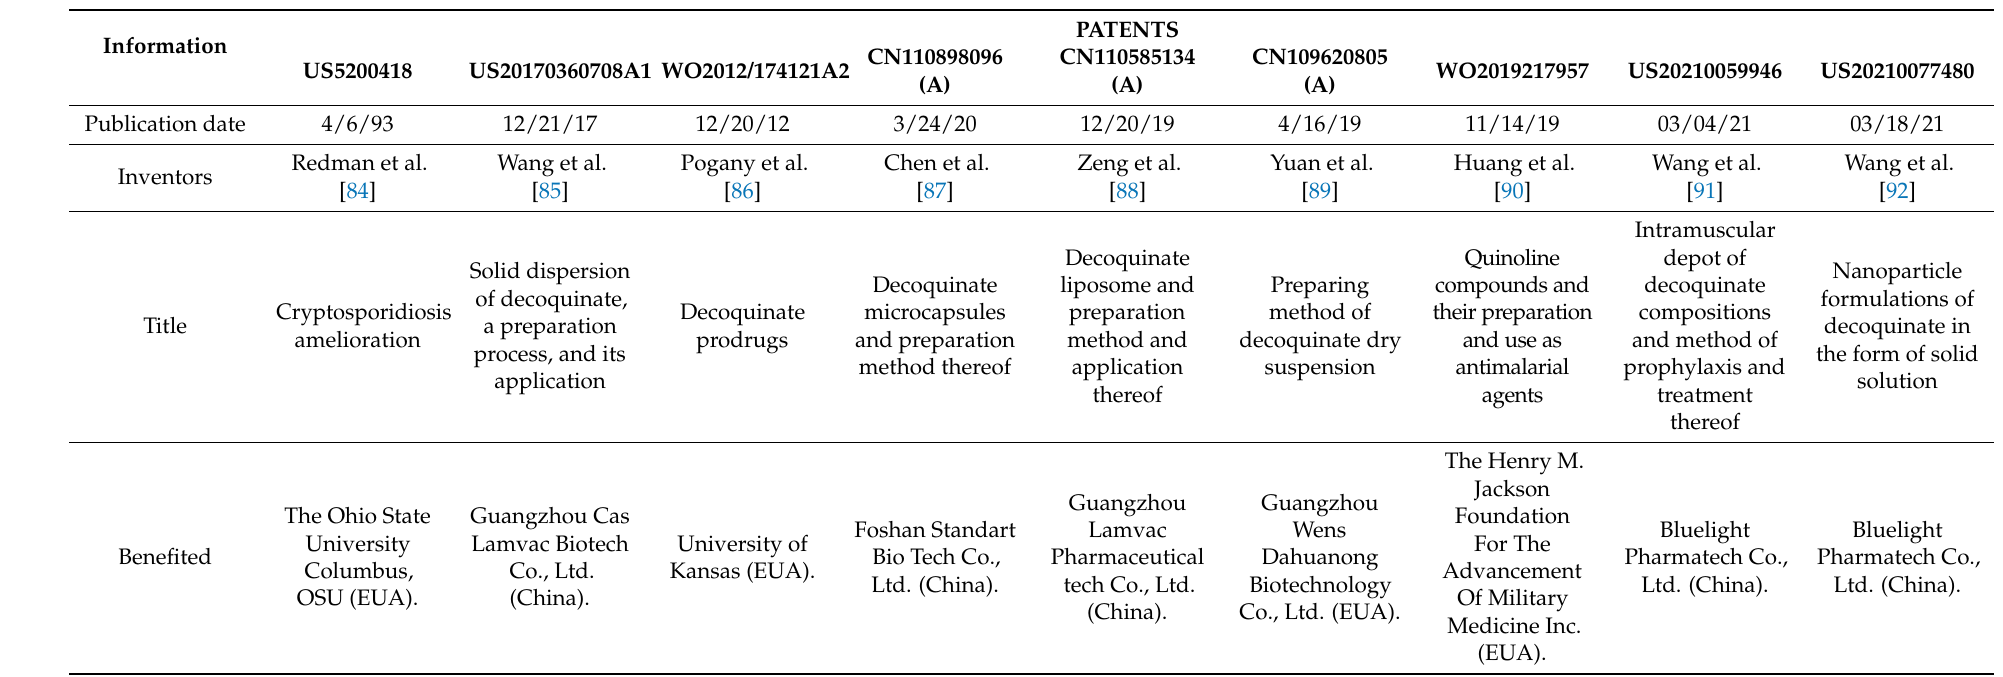
Table 4. Summary of patents related to the use of pharmaceutical technology approaches to improve the biopharmaceutical properties of